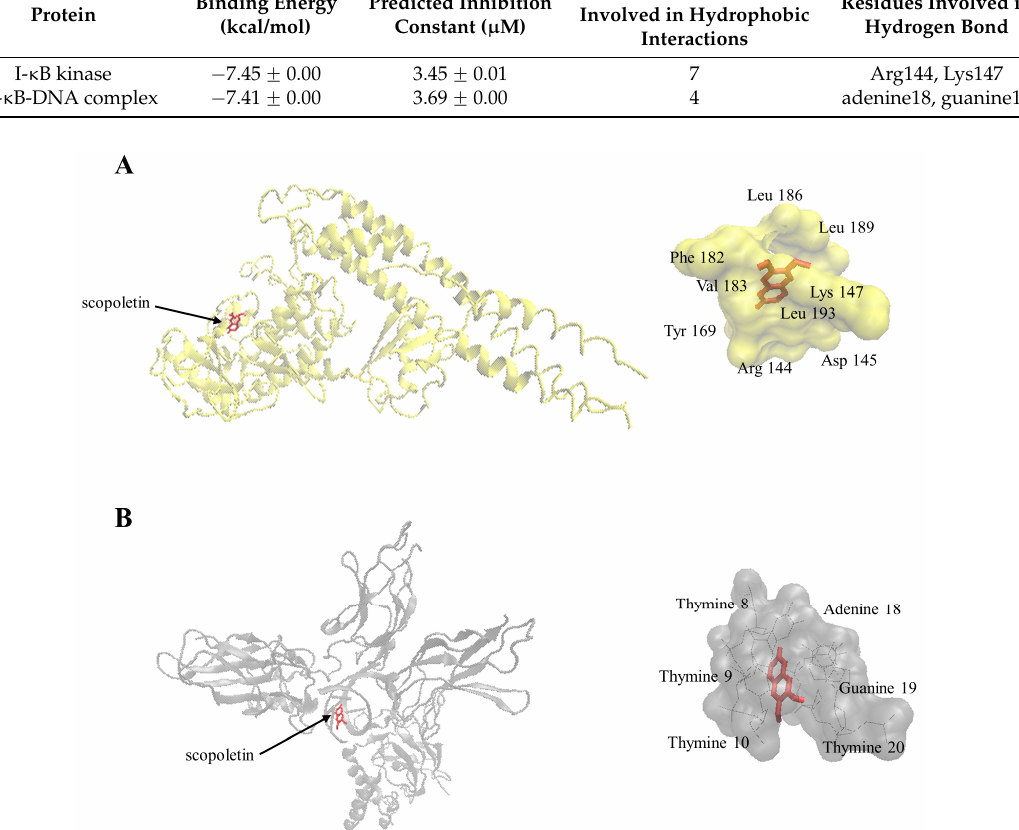
Table 4. Molecular docking of scopoletin to NF- κ B pathway proteins (details see Figure 8). Number of Residues Residues Involved in Binding Energy Predicted Inhibition Molecules 2016 , 21 , 496 11 of 22 Involved in Hydrophobic Protein Hydrogen Bond (kcal/mol) Constant ( µ M) Interactions but not to free NF- κ B and the I- κ B kinase-NEMO complex (data not shown). Hence, scopoletin may I- κ B kinase ´ 7.45 ˘ 0.00 Arg144, Lys147 NF- κ B-DNA complex 4 adenine18, guanine19